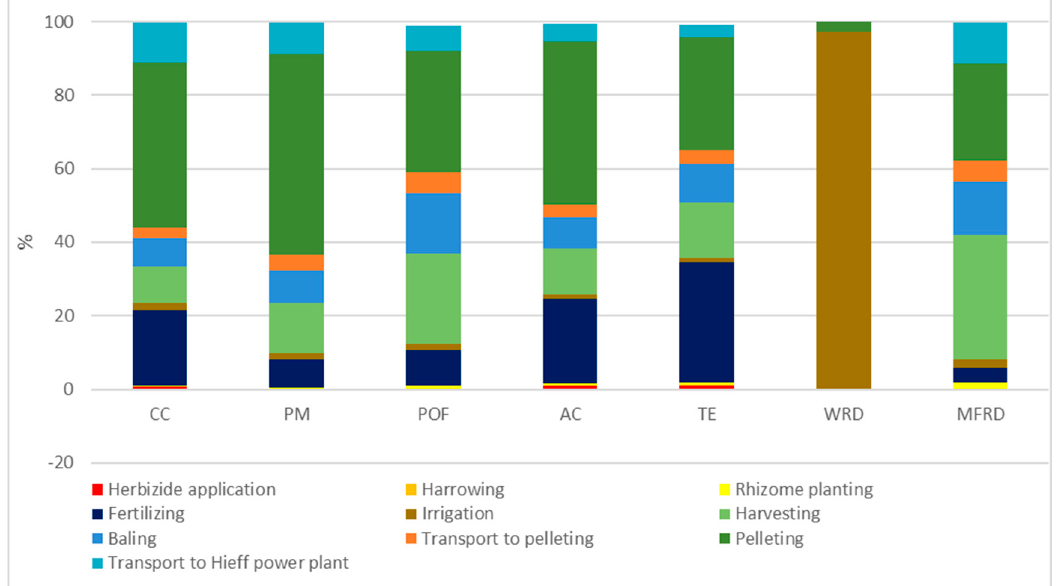
Figure 5. Main contributions to the environmental impact of Miscanthus pellets supplied to the HBP CHP plant. CC = Climate change, PM = Particulate matter, POF = Photochemical ozone formation, AC = Acidification, TE = Terrestrial eutrophication, WRD = Water resource depletion, MFRD = Mineral, fossil, and renewable resource depletion.